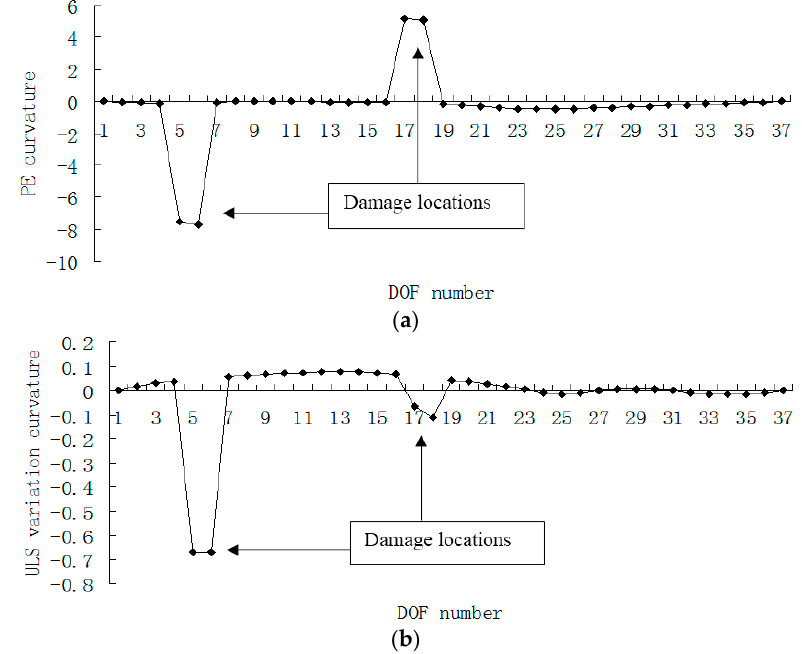
Figure 10. ( a ) Damage index (PE curvature) map using the first four exact modes when the defects occurred in elements 5 and 17; ( b ) Damage index (ULS variation curvature) map using the first four exact modes when the defects occurred in elements 5 and 17 (×10 − 3 ).